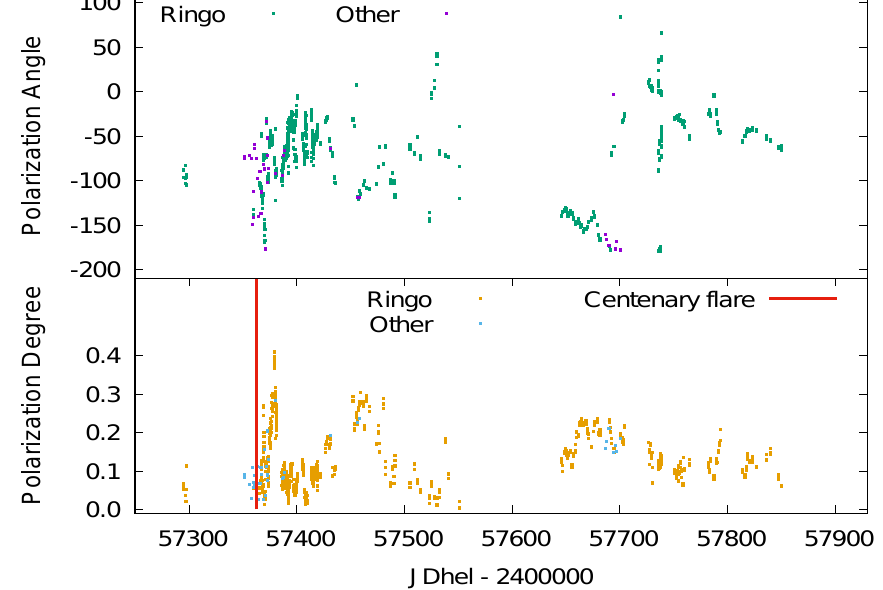
Figure 3. Polarimetric data for OJ 287 from September 2015 to May